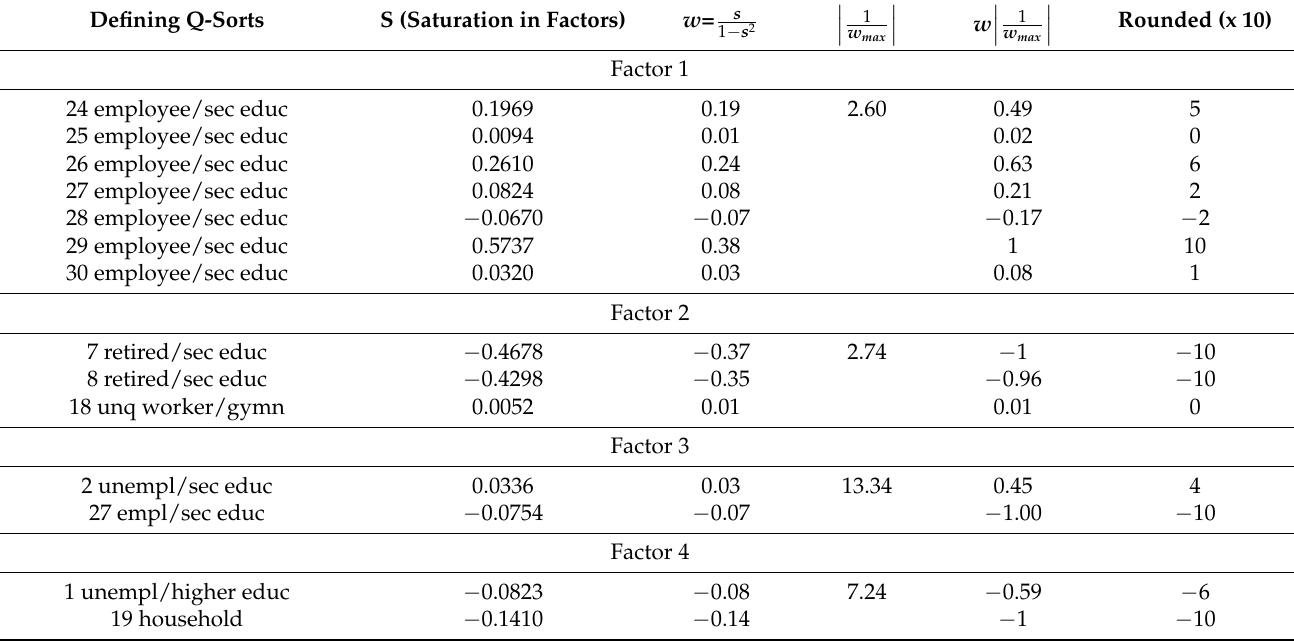
Table 2. Generating the weights of each Q-sort based on saturations in